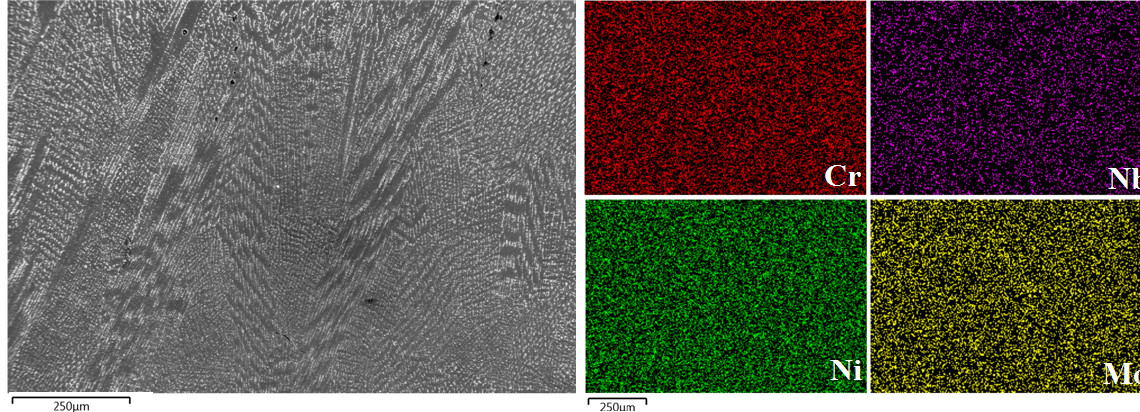
Figure 10: Quality EDS analysis of chromium, nickel, niobium and molybdenum map distribution in lower layers